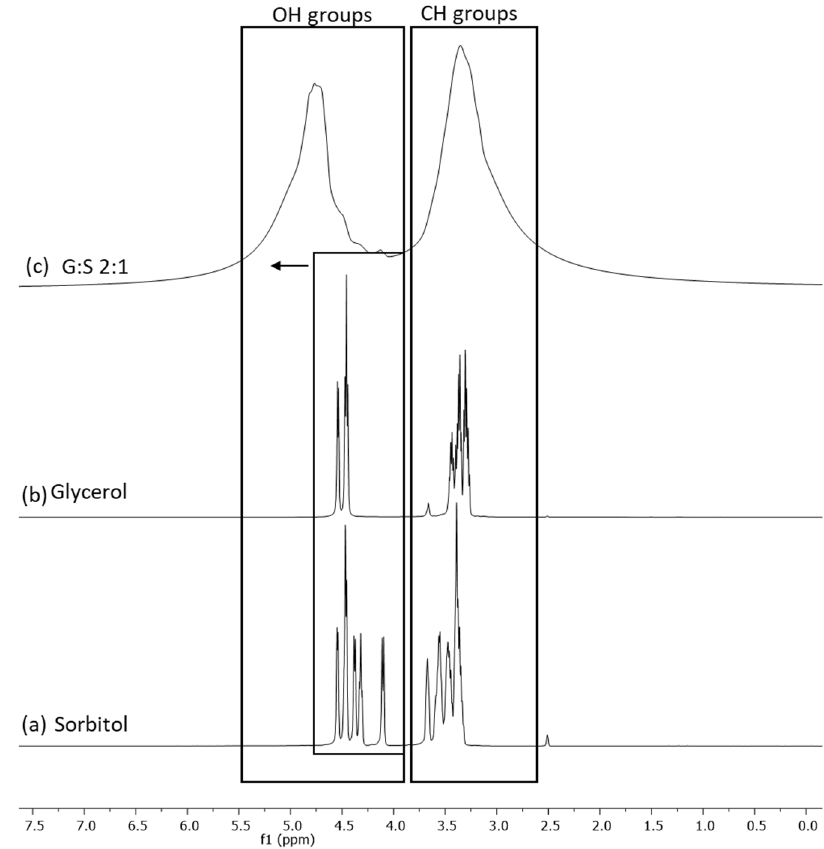
Figure 2. H 1 NMR spectra of: ( a ) sorbitol, ( b ) glycerol, and ( c ) G:S 2:1 molar ratio.